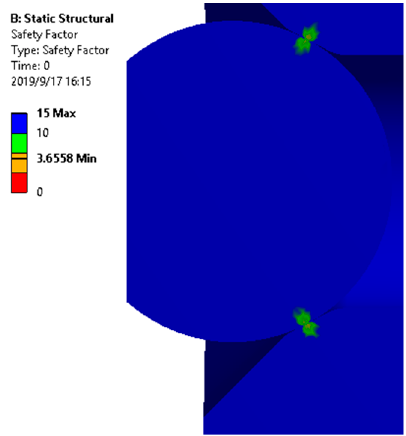
Figure 12. The distribution of fatigue safety factor.